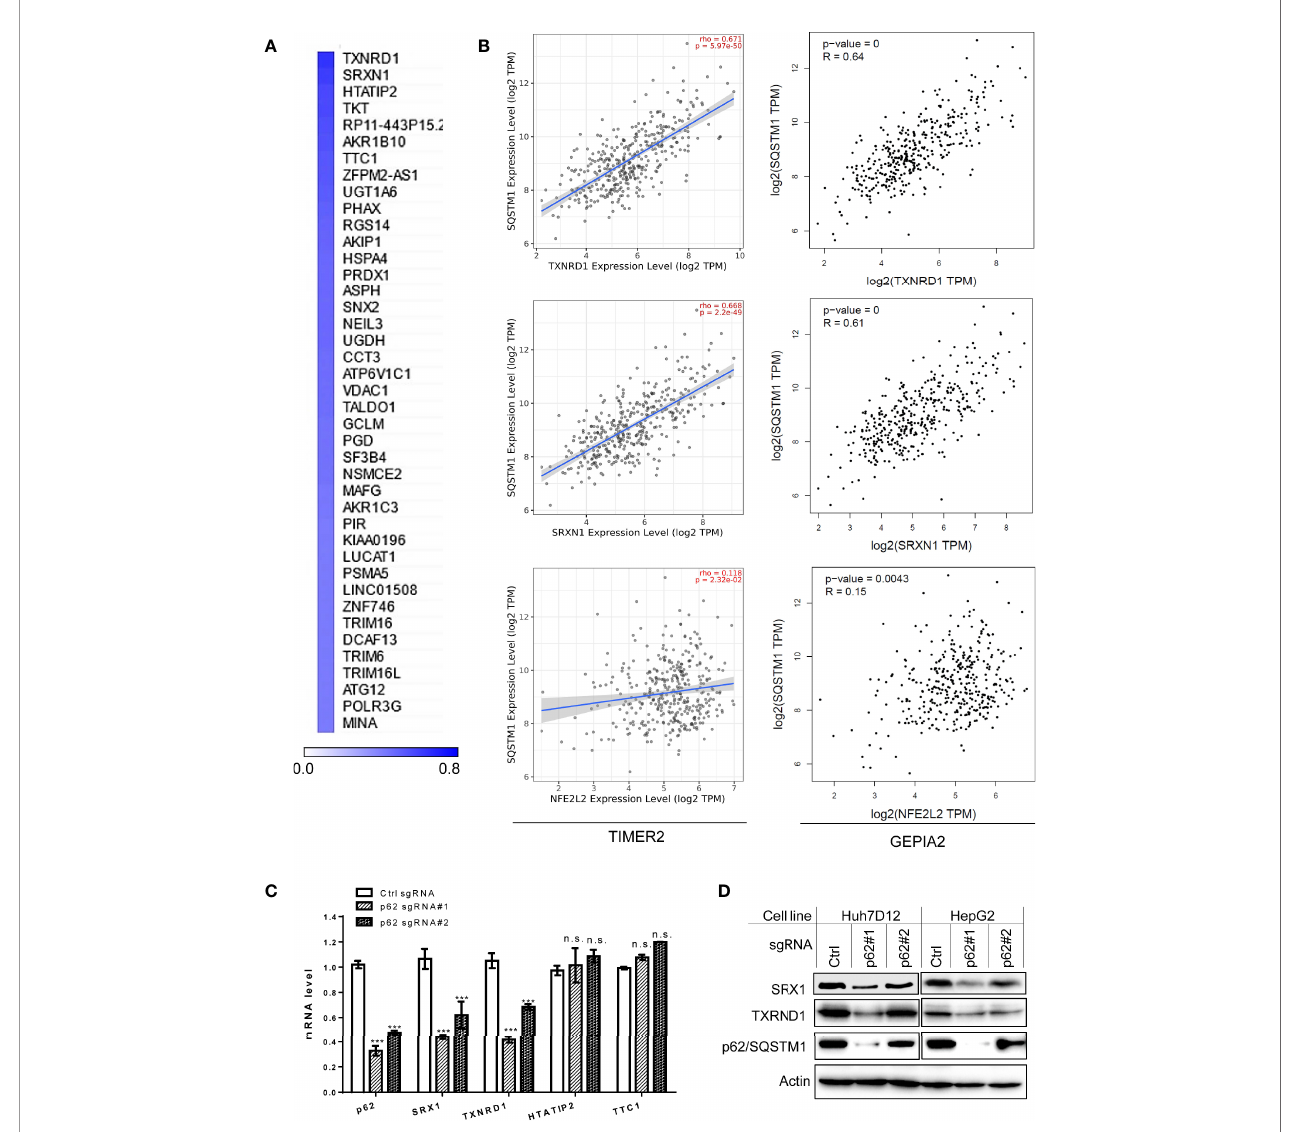
FIGURE 7 | Sqstm1-associated molecular signature in LIHC. (A) Top 40 genes correlated with Sqstm1 at the expression level in LIHC, with Pearson correlation coef fi cient values (PCC) >0.5. (B) Validation of individual genes in association with Sqstm1 at the transcriptional level. Results were obtained from TIMER2 (left) and GEPIA2 (right). (C, D) p62/Sqstm1 depletion downregulates SRX1 and TXNRD1 expression at both transcriptional and translational levels. In qPCR results, the mRNA level of each sample with control sgRNA was set to 1. ***p < 0.001. n.s., not signi fi